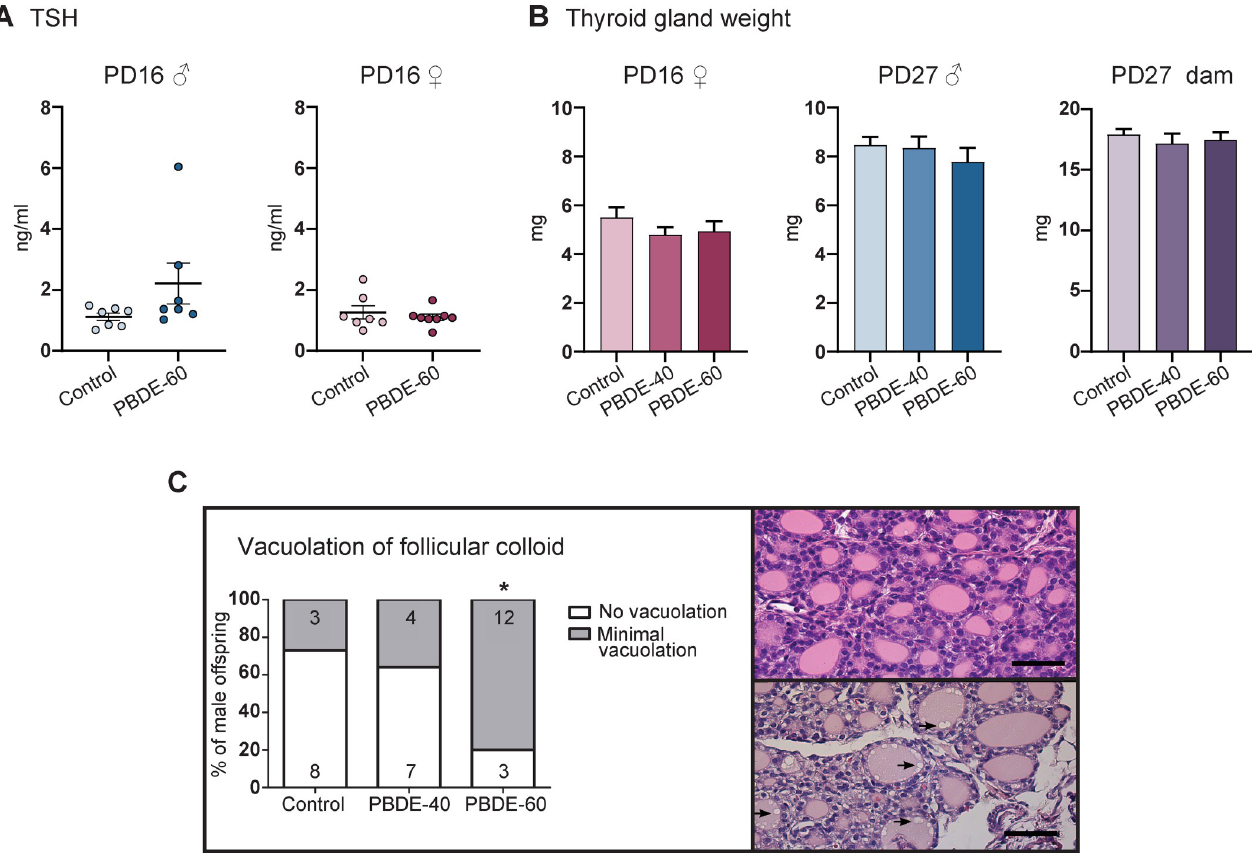
Fig 5. Effects on the hypothalamic-pituitary-thyroid axis in rat offspring exposed to DE-71 during development. (A) TSH concentrations in PD16 male and female offspring. Individual data points shown with mean and SEM whiskers. n = 7–8. (B) Thyroid gland weights in female offspring PD16, male PD27 and dams PD27. Females: n = 19–21, males: n = 15–17, Dams: n = 19–21. (C) Vacuolation of thyroid gland follicular colloid in male PD16 offspring. Left: incidences of vacuolation and severity, number of assessed male pups shown inside bars. Upper right: Thyroid gland with no vacuolation of follicular colloid. Lower right: thyroid gland with minimal vacuolation (arrows) of follicular colloid. � p < 0.05. Scalebar = 50 μ m. PBDE: polybrominated diphenyl ethers (DE- 71), PD: postnatal day, TSH: thyroid-stimulating-hormone.